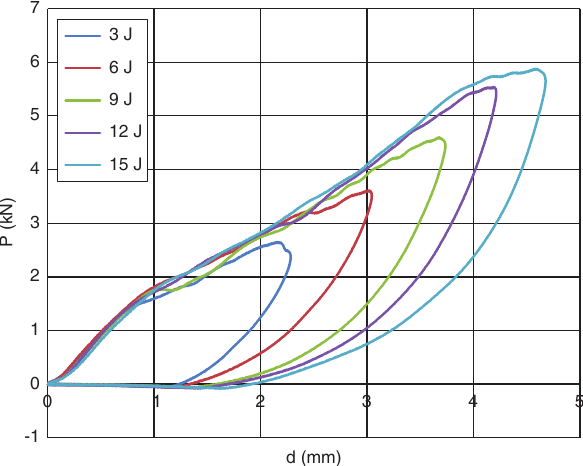
Figure 4 Impact load-deflection curve for 12 layers.